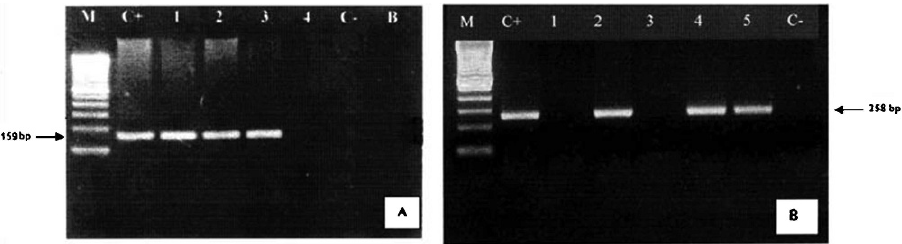
Figure 1 - Electrophoresis: A-N-PCR-amplified HCMV DNA of 4 peripheral blood samples (159 bp). B-N-PCR-amplified HHV-6 DNA of 5 peripheral blood samples. Agarose gel 2% ethidium bromide staining and photographed under UV light. M= molecular weight standard (Ladder 100 bp). C + = positive control; C– = negative control; B = water.